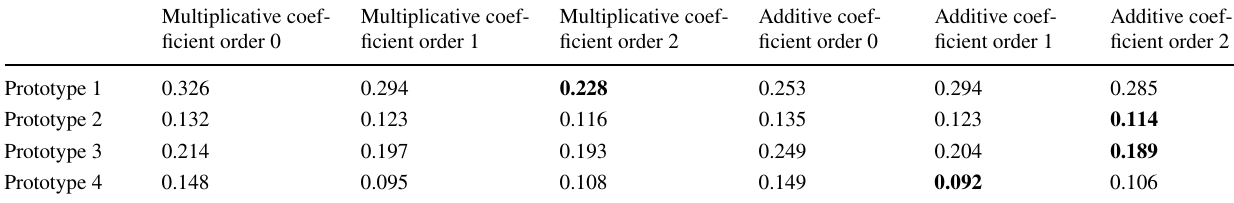
Table 5 Root mean squared errors computed on validation data